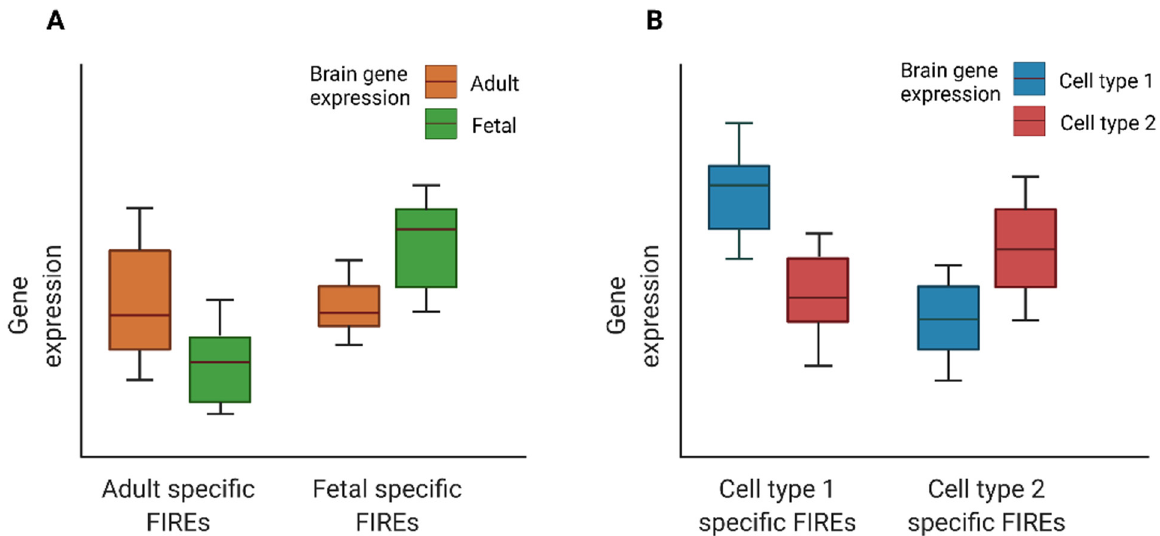
Figure 3. Cartoon illustration of expression for genes overlapping developmental time- or cell type-specific FIREs: ( A ) Boxplots of expression for genes overlapping fetal or adult brain FIREs. ( B ) Boxplots of expression for genes overlapping cell type specific FIREs. The figure was inspired by results presented in Schmitt et al. [11] and Crowley et al. [66].